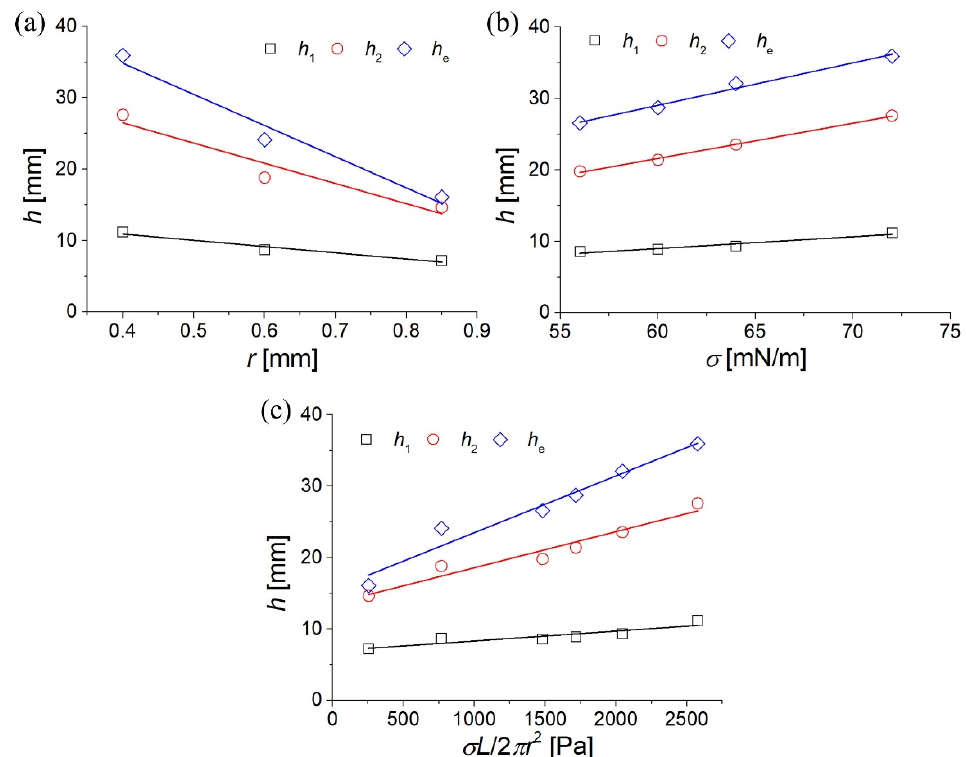
Figure 9. ( a ) Characteristic heights ( h 1 , h 2 , and h e ) as a function of the capillary tube radius ( r ). ( b ) Characteristic heights as a function of the surface tension of liquids ( σ ). ( c ) Characteristic heights as a function of the quantity in terms of r and σ ( σ L /2 π r 2 ). Solid lines represent linear fits between characteristic heights and each comparative parameter.